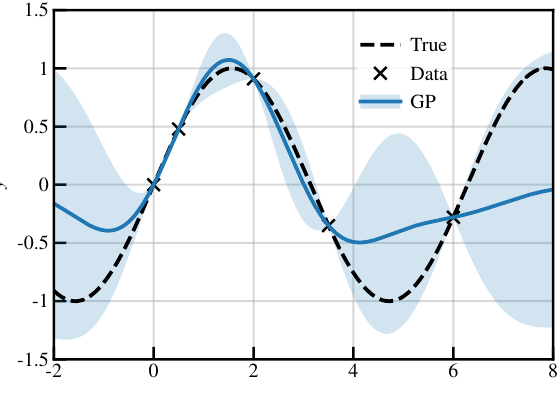
Figure 2. Demonstration of Gaussian process regression. The true function is y = sin ( x ) , and the data points are at x = 0,0.5,2,3.5,6 . The solid line represents the GP mean, and the shaded areas { } give the 2 σ confidence intervals. The optimised kernel parameters are η 2 = 0.602, (cid:96) = 1.063. See text for